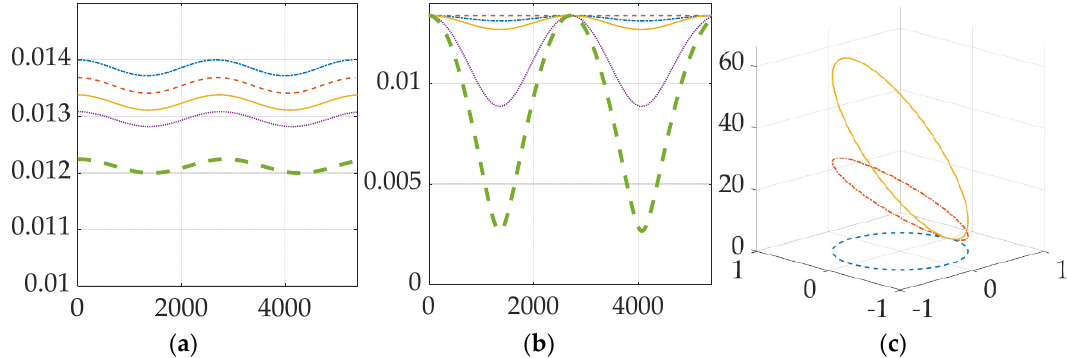
Figure 6. Lorentz force extracted from electrodynamic tether with time in seconds on the abscissa and ( a ) Altitude (kilo-